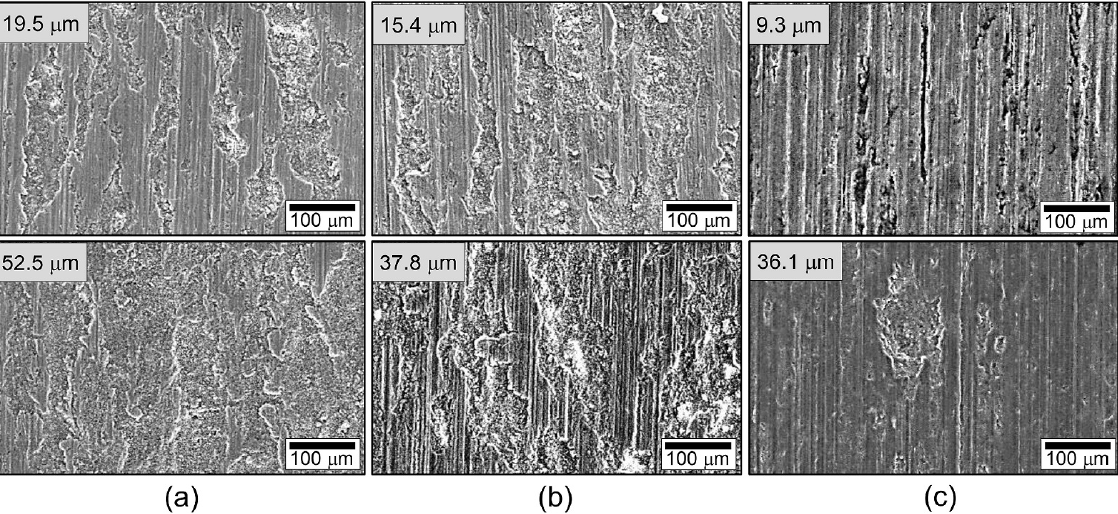
Figure 11. Typical SEM images of worn regions in the ( a ) Al-3.2 wt.% Bi, ( b ) Al-3.2 wt.% Bi-3.0 wt.% Zn, and ( c ) Al-3.2 wt.% Bi-3.0 wt.% Cu alloys (all images obtained after 60 min of wear test and values inside represent λ Bi in μ m).